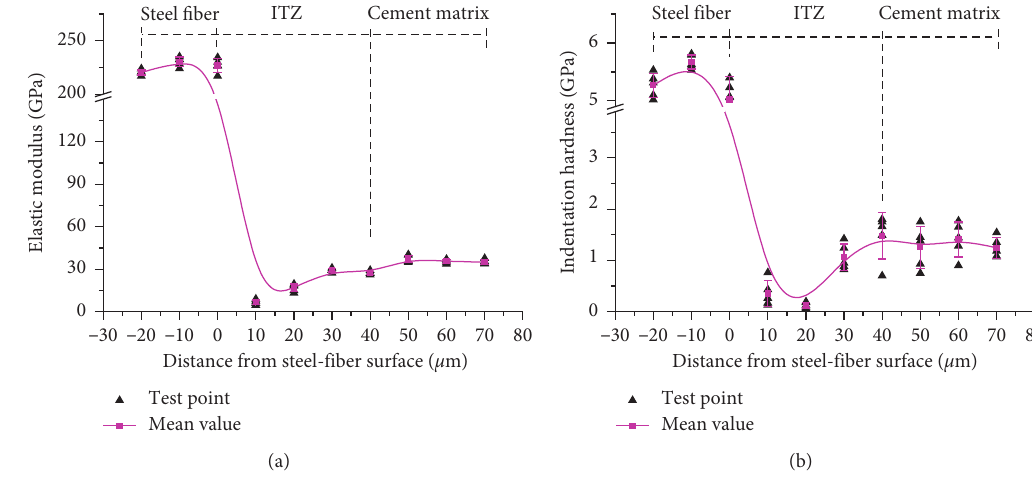
Figure 4: Test indices versus distance from the steel-fiber surface. (a) Elastic modulus. (b) Indentation